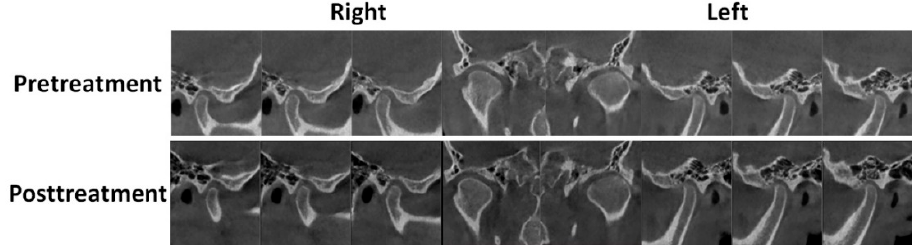
Figure 16. Sagi tt al and coronal CBCT images on the right and left condyles at pretreatment and Figure 16. Sagittal and coronal CBCT images on the right and left condyles at pretreatment and pos tt reatment.